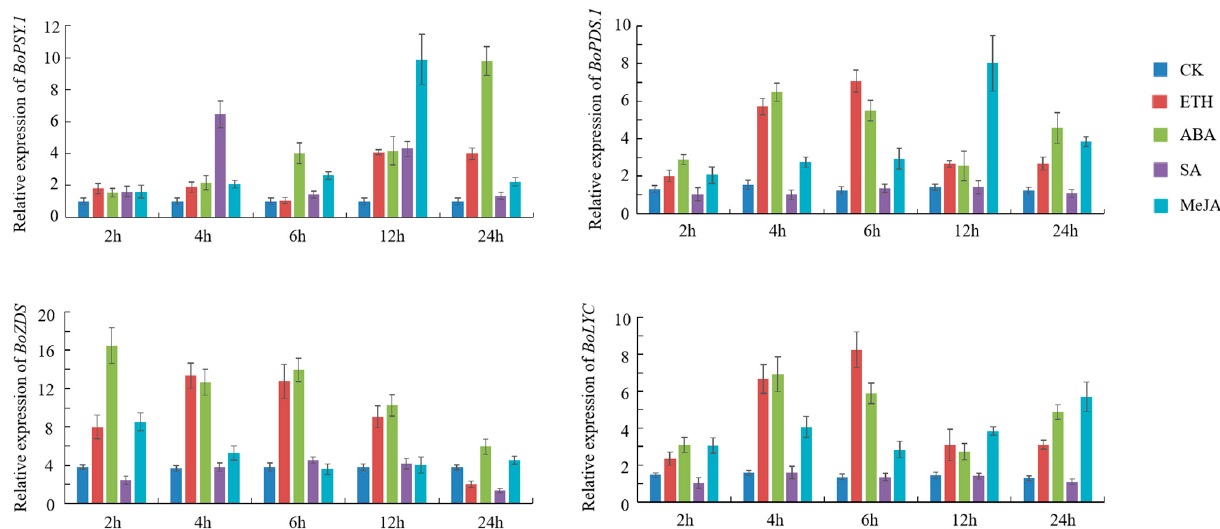
Figure 6. The expression of BoPSY.1 , BoPDS.1 , BoZDS , and BoLYC after treatment with exogenous phytohormone. The Y -axis and X -axis represent the relative expression level and the time course of exogenous phytohormone treatment, respectively. Leaves were sampled at 0, 2, 4, 6, 12, and 24 h after ETH, ABA, SA, and MeJA spraying. Data represent the mean ± SD of three technical repetitions.